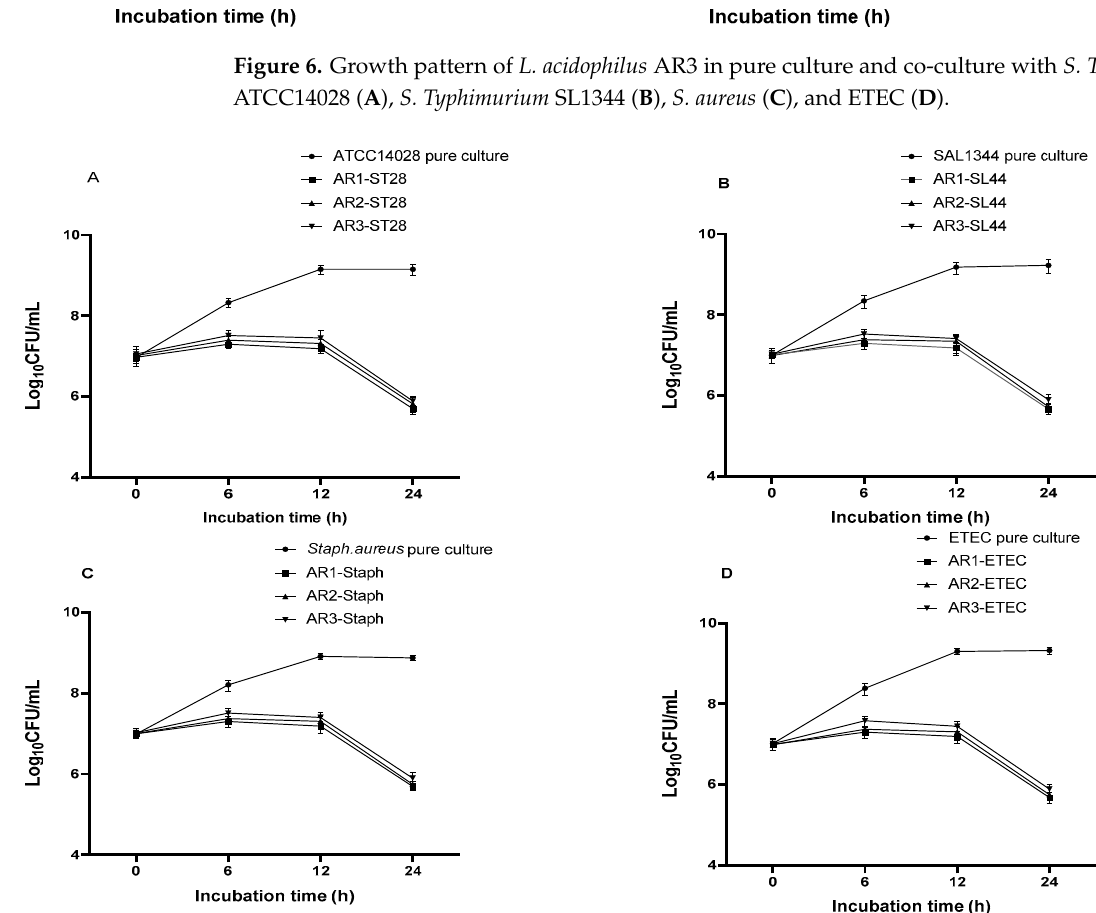
Figure 7. Growth pattern of S. Typhimurium ATCC14028 ( A ), S. Typhimurium SL1344 ( B ), S. aureus ( C ), and ETEC ( D ) in pure and co-culture with different Lactobacilli .